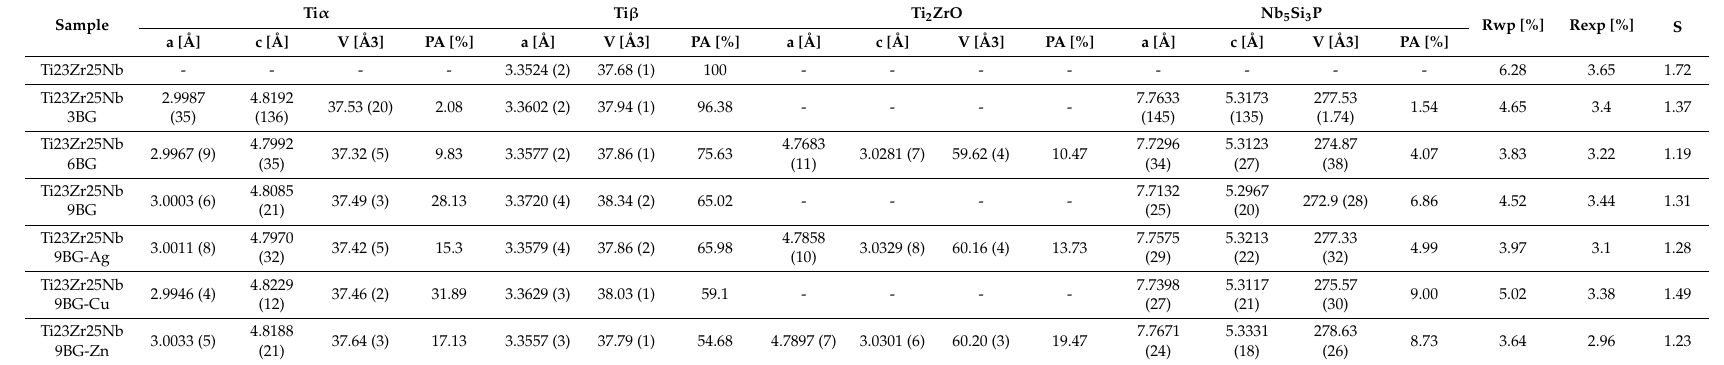
Table 2. Crystallographic data analysis of bulk Ti23Zr25Nb-based composites with the 3, 6, 9 wt.% 45S5 Bioglass and 1 wt.%. Ag, Cu, Zn content in contrast to the Ti23Zr25Nb